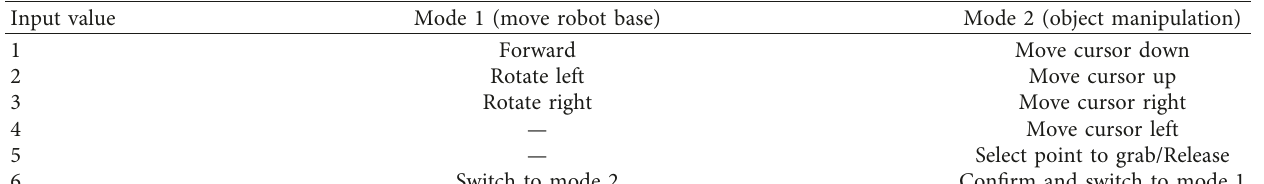
Table 2: Modes of operation.